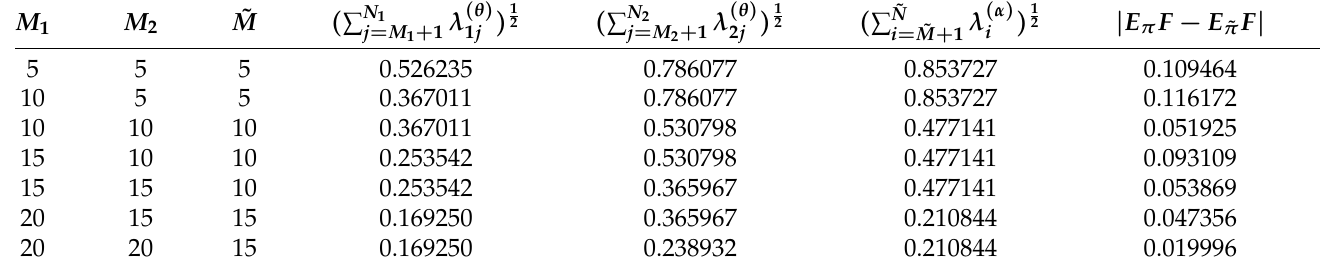
E π F E ˜ π F when the K-L expansion is truncated to M terms for different facies. | − |